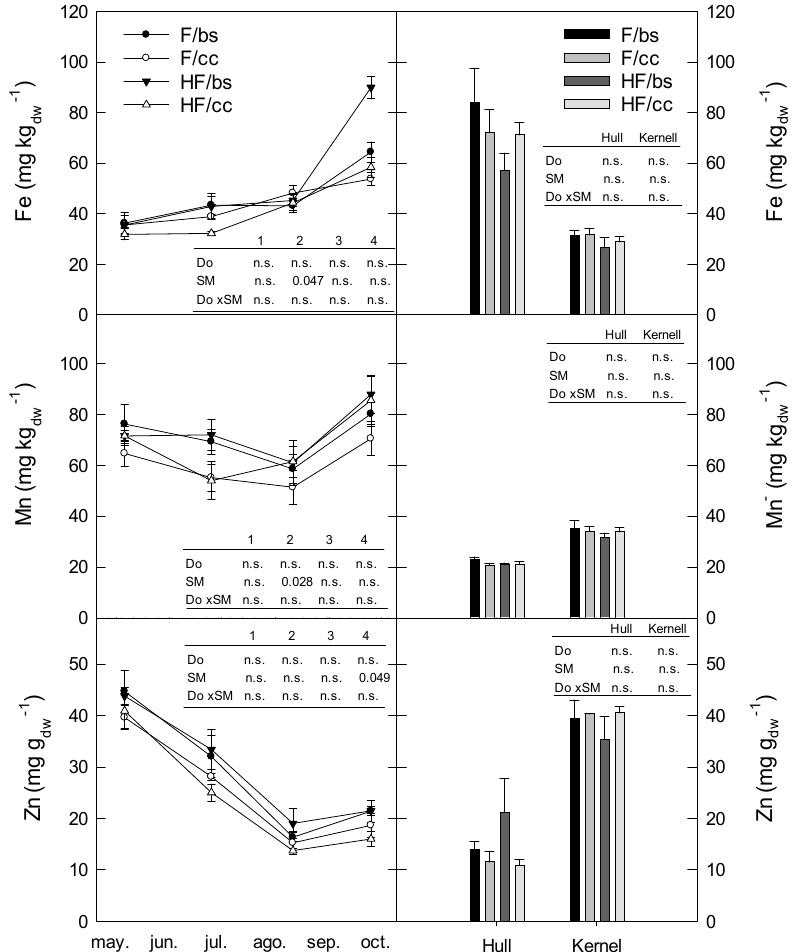
Figure 3. Effects of the fertigation dose (Do)(farmer (F) and half farmer (HF)), soil management (SM) (bare soil (bs) and cover crops (cc)) and its interaction on the Fe, Mn and Zn concentration in leaves, hull and kernel tissue in the 2020 season. Data shows the mean ± standard error. Numbers 1 to 4 indicated the leaf harvest sample date; 6 April, 25 June, 11 August and 25 September, respectively. means that the factor analyzed is not significant, and when significant the p -value is